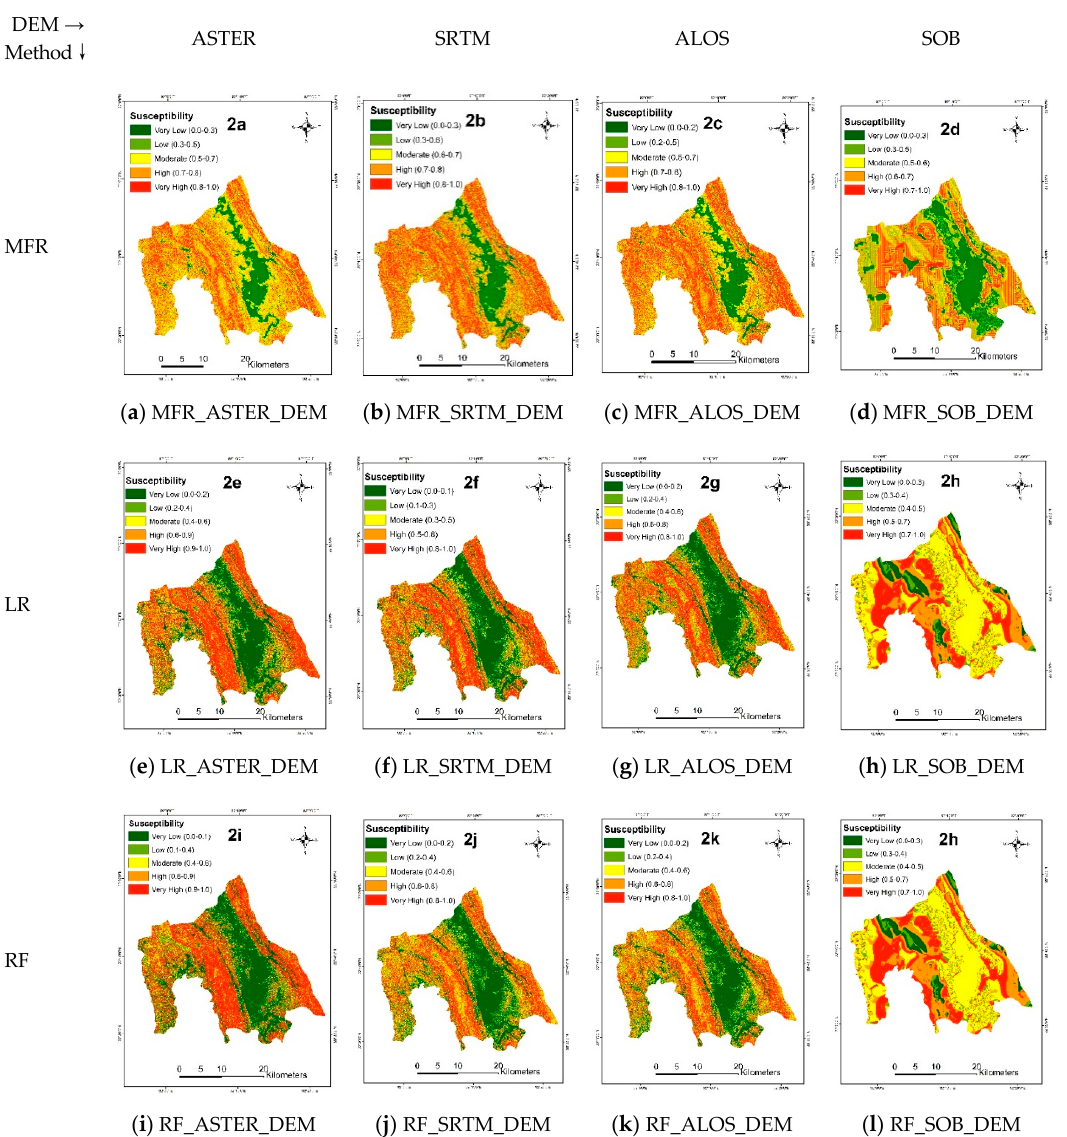
Figure 2. Landslide susceptibility maps produced using Modified Frequency Ratio (MFR), Logistic Regression (LR) and Random Forest (RF) models (seven DEM ‐ based factors).